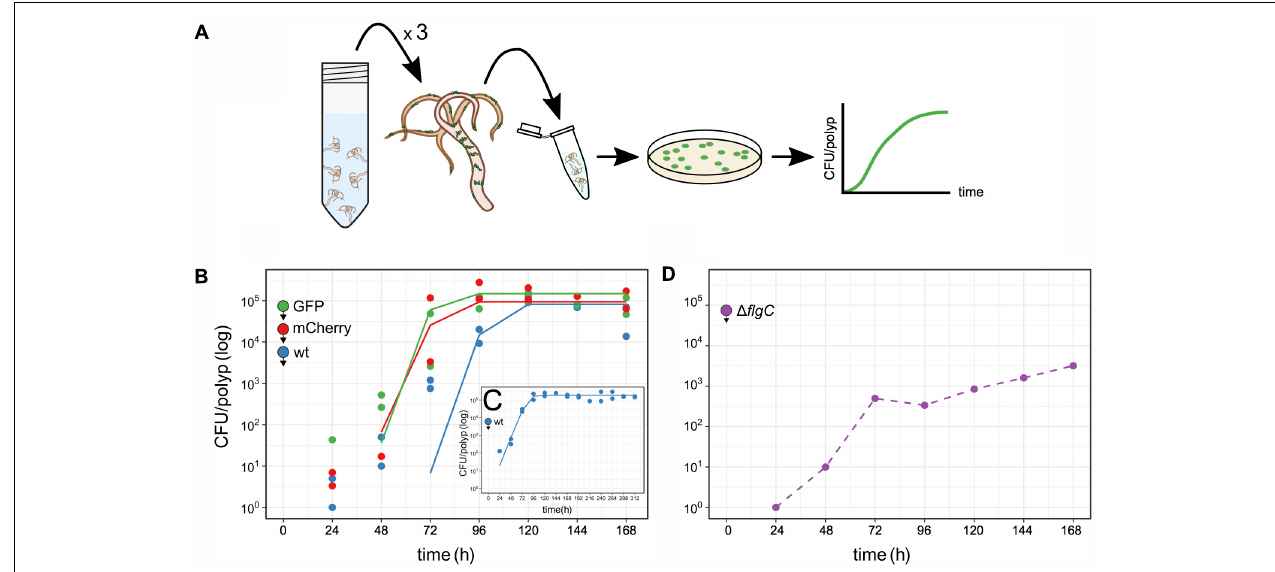
FIGURE 3 | Quantification of Curvibacter population size on Hydra . (A) Schematic of the assay pipeline to follow colonization dynamics over time. Every 24 h, three polyps were sampled, homogenized, and the homogenate plated. (B–D) Population size of Curvibacter on Hydra over time. Hydra pools were incubated with 100 (B,C) or 10 4 (D) cells per polyp (see section “Materials and Methods” for details). Filled circles with arrowheads indicate the bacterial strain and its arrival time on Hydra . (B) Population size of three differently labeled but otherwise isogenic populations [ n = 2, wild type (wt), pRL153-GFP, and pTW1-mCherry] estimated from independent Hydra pools over time. Solid lines represent the best fit of a logistic growth model (wt P -value = 1.7 × 10 − 4 , GFP P -value = 9.0 × 10 − 6 , mCherry P -value = 5.4 × 10 − 5 ). (C) Long-time population size dynamic of Curvibacter on Hydra over 312 h shows logistic growth ( n = 2, P -value = 4 × 10 − 11 ).